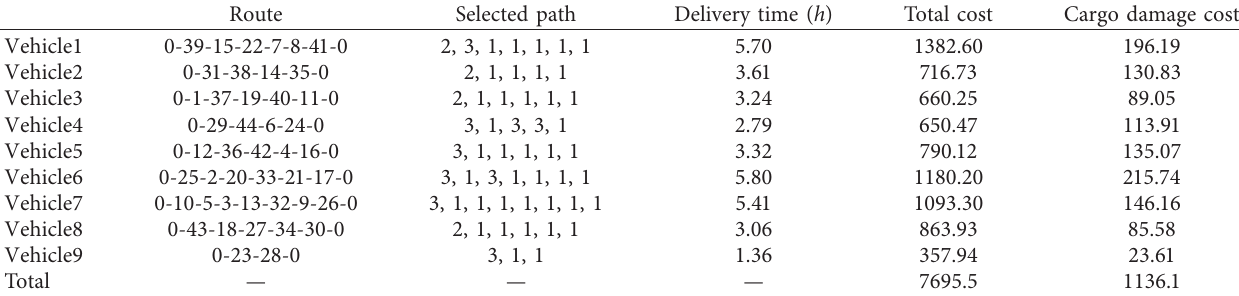
Table 7: The delivery routes corresponding to the optimal solution in the preoptimization stage.